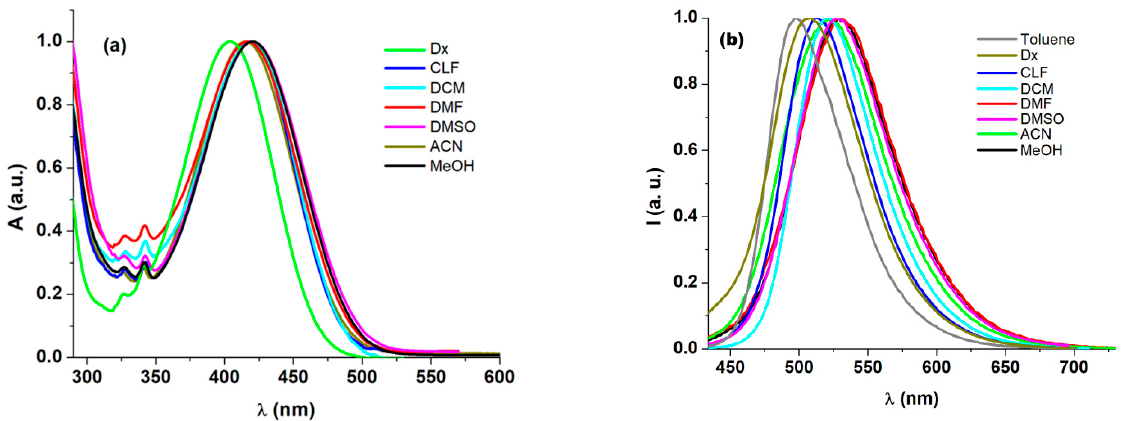
Figure 2. Normalized ( a ) UV-vis absorption and ( b ) fluorescence spectra ( λ ex = λ a ) of 7 in different solvents.